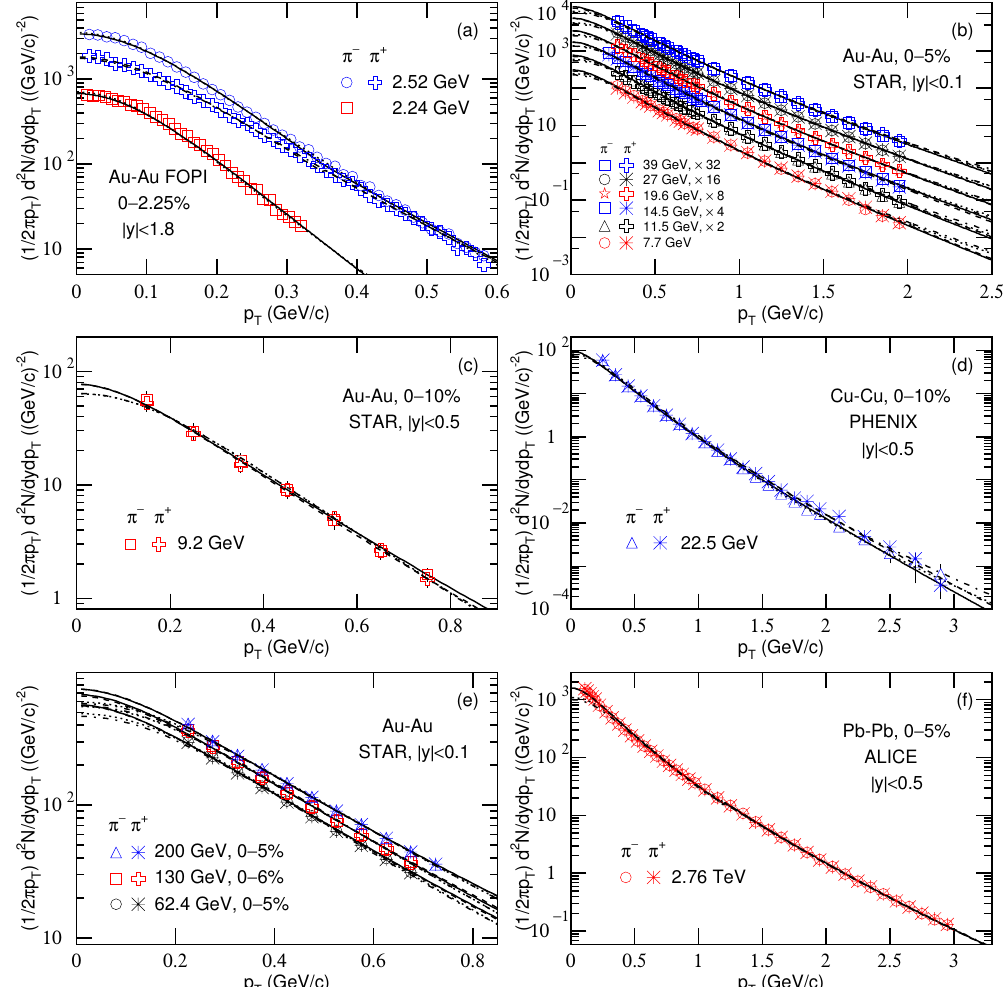
Figure A2. Same as Figures 4 and A1, but showing the results from central AA collisions and Equation (8). Panels ( a – f ) represent the data by various symbols measured in different collisions by different